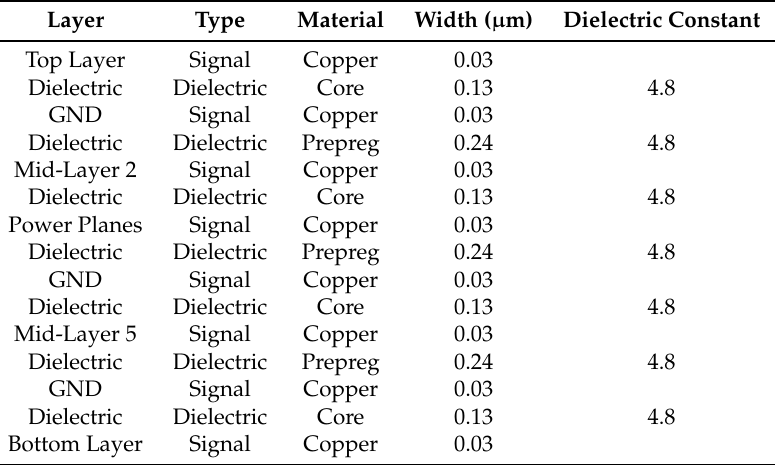
Table 5. Manufacturing parameters of the PCB